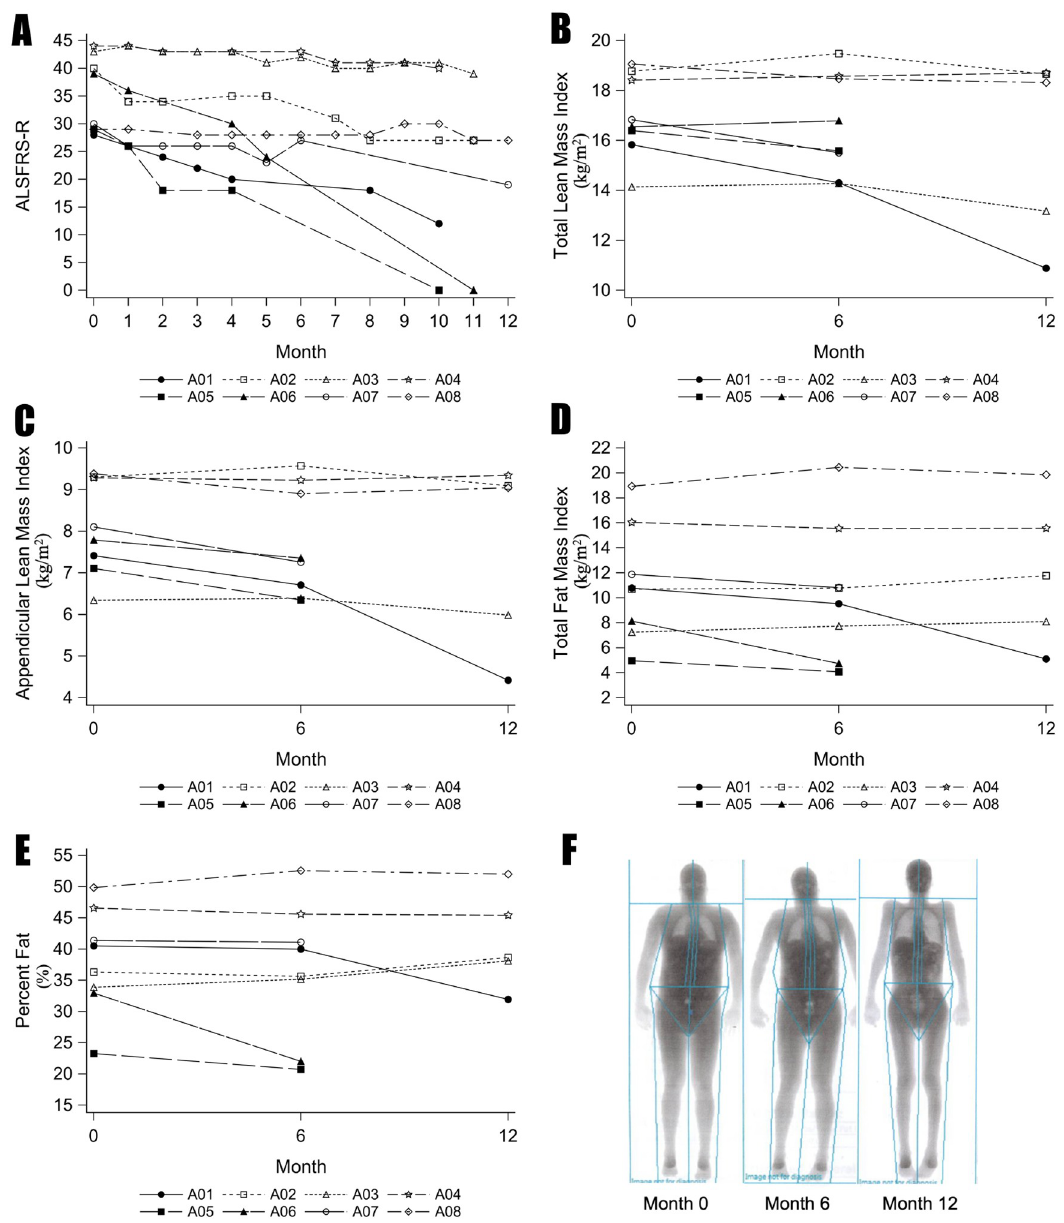
Fig 2. Baseline and change in DEXA measurements in ALS patients with two or more scans over the study period. (A) ALSFRS-R, (B) Total Lean Mass Index, (C) Appendicular Lean Mass Index, (D) Total Fat Mass Index, and (E)) Percent Fat. Fast progressors are indicated with filled symbols and intermediate to slow progressors are indicated with open symbols. (F) Serial DEXA scans of patient A01 who was a fast